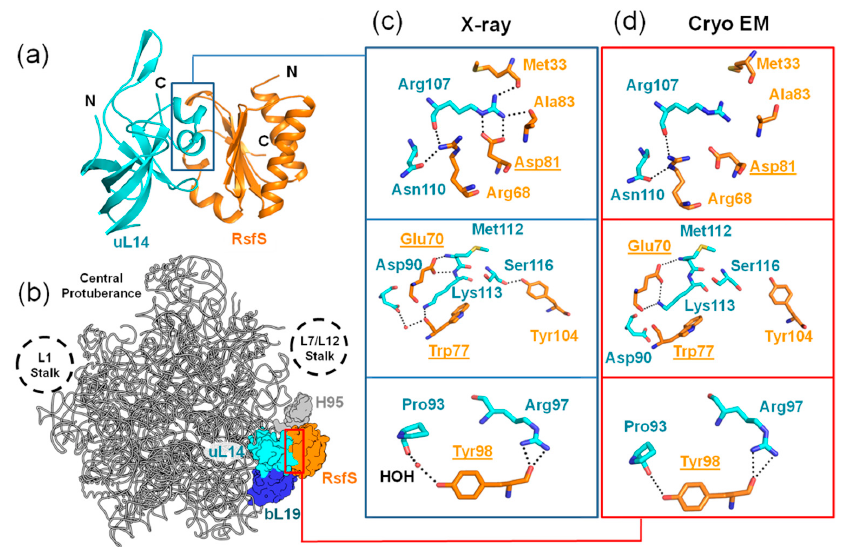
Figure 1. The interaction of RsfS with uL14 and the 50S ribosomal subunit from S. aureus . ( a ) The crystal structure of the RsfS–uL14 heterodimer (PDB: 6SJ5). ( b ) The cryo-EM structure of the 50S–RsfS complex from S. aureus (PDB: 6SJ5). ( c , d ) The contacting amino acid residues at the interface between uL14 and RsfS from X-ray and cryo-EM structures, respectively. Potential H-bonds are represented by dashed lines. Water molecules (HOH) are represented by red spheres. The chosen amino acid residues for replacement are underlined.